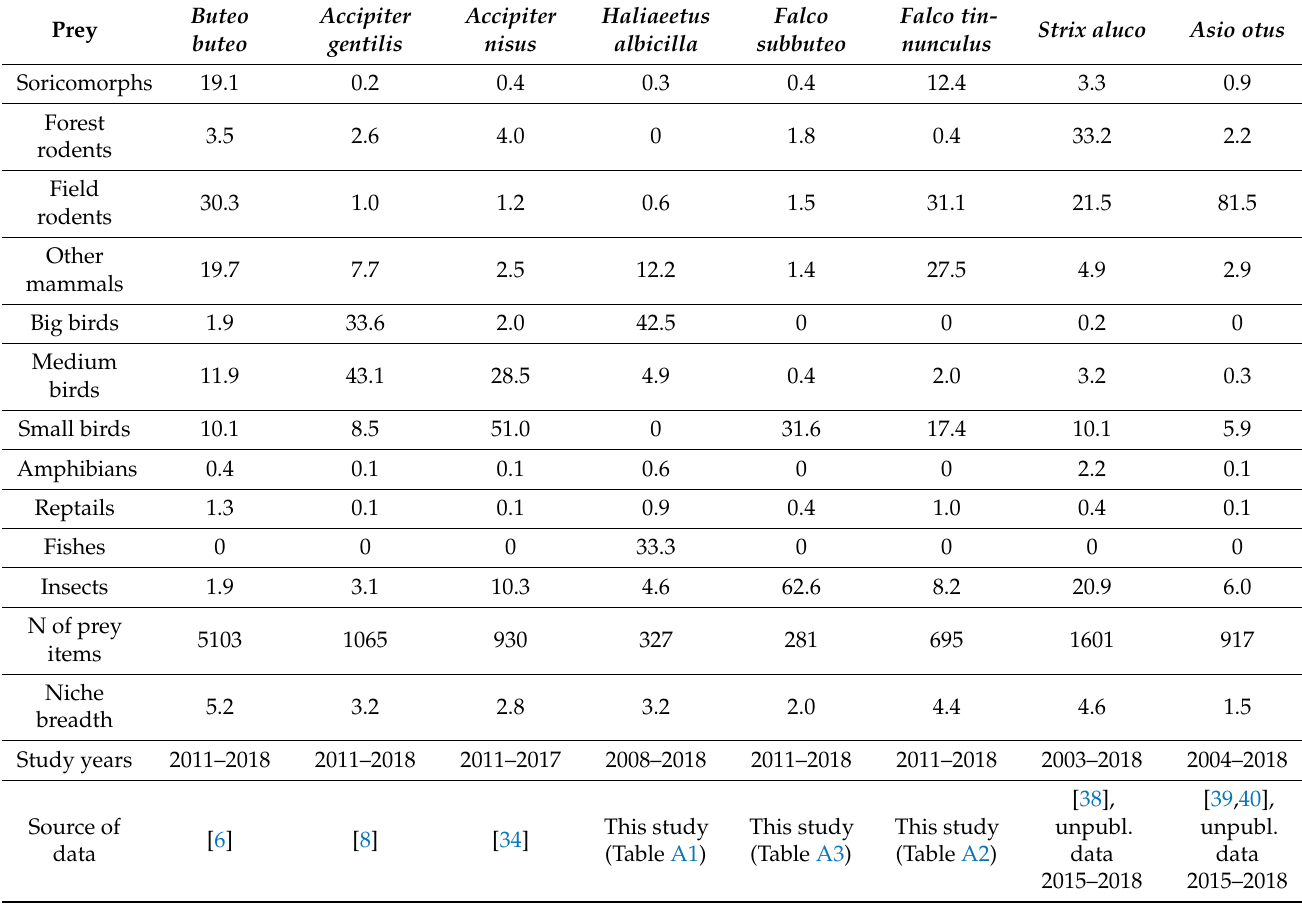
Table 2. The diet composition (% of each type of prey) and niche breadth of avian predators in the breeding season in the area of study (central Poland, vicinity of Rog ó w village, Experimental Forest Station of Warsaw University of Life Sciences), based on pellet analysis and prey remains collection. The food niche breadth was calculated according to the Simpson